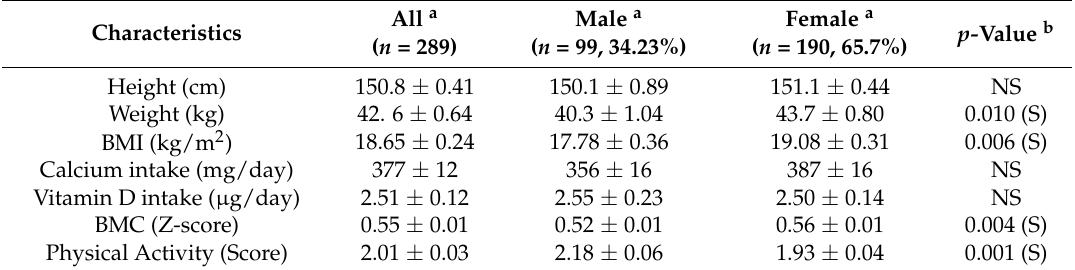
Table 1. Characteristics of participants according to gender ( n = 289).